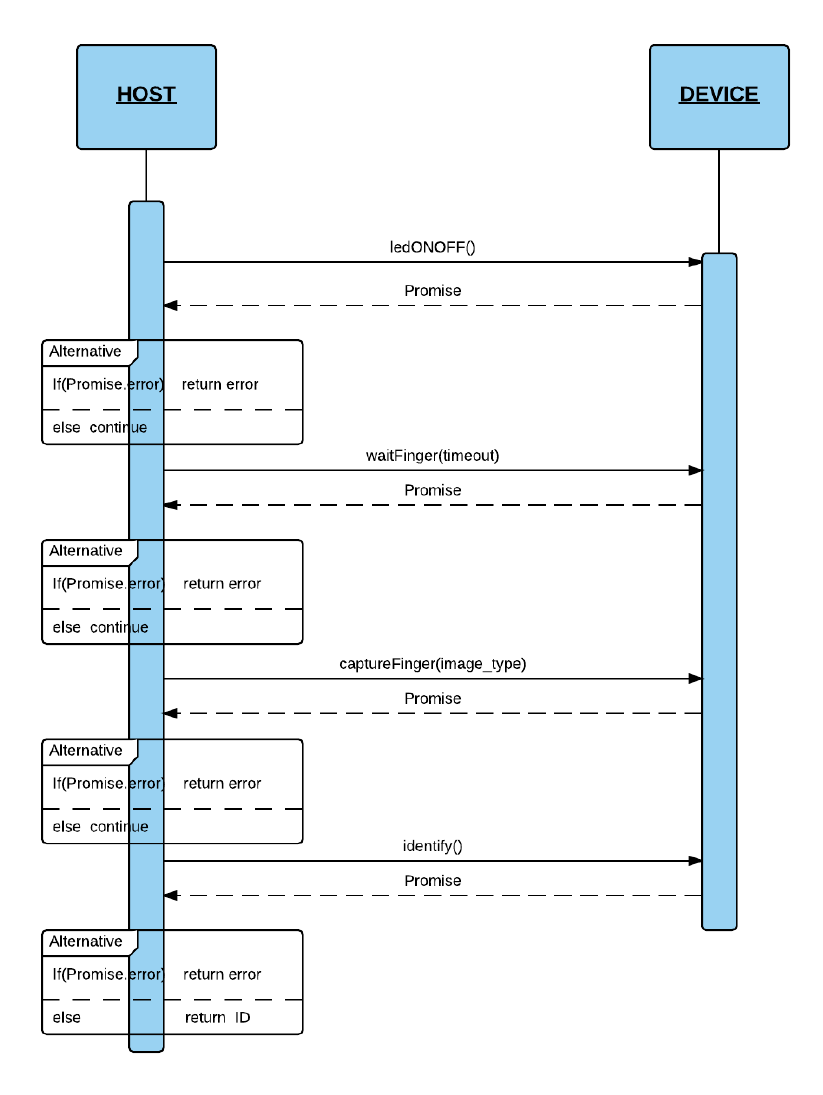
Figure 5. Identify